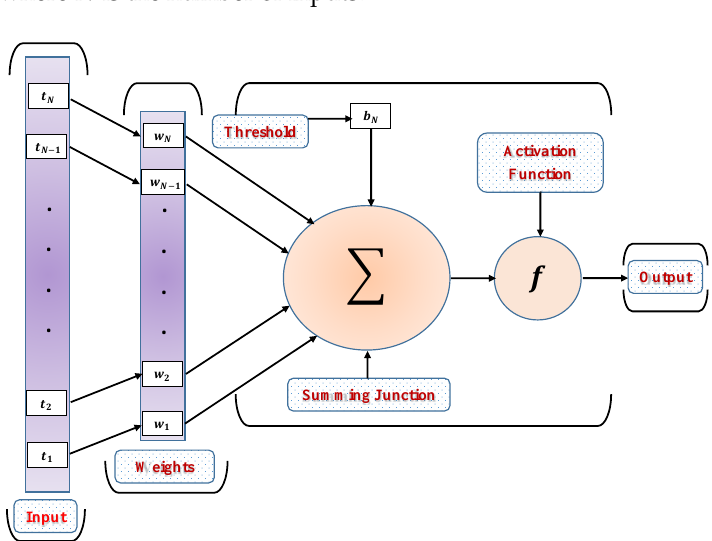
Figure 2. Basic structure of a simple artificial